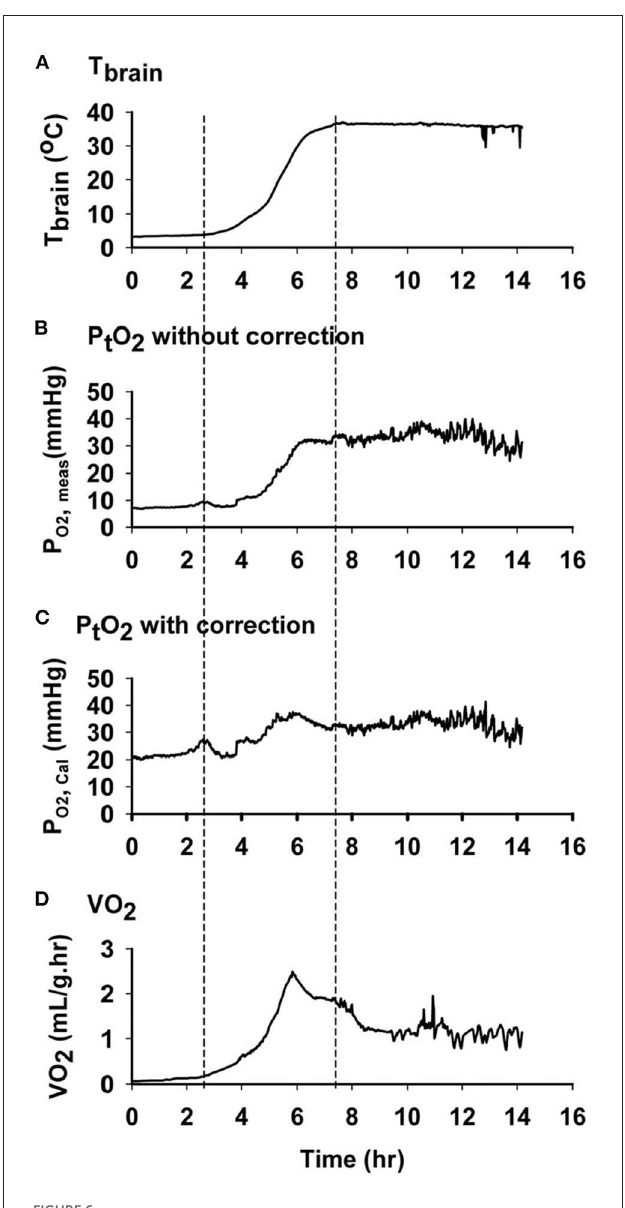
FIGURE6 Oxygen concentration in AGS brain tissue does not decrease during arousal, despite a decrease in oxyhemoglobin. Data shown are representative graphs from a single AGS collected during an induced arousal from hibernation torpor at an ambient temperature of 2 ◦ C. First and second dashed line from left shows the time when arousal and euthermia started. (A) Changes in brain temperature during arousal. (B) Changes in PtO 2 without temperature correction (P O 2 , meas). (C) Changes in calculated PtO 2 with temperature correction (P O 2 , Cal). (D) Changes in the rate of oxygen consumption (VO 2 ) measured by open flow respirometry [Ma and Wu (51) with